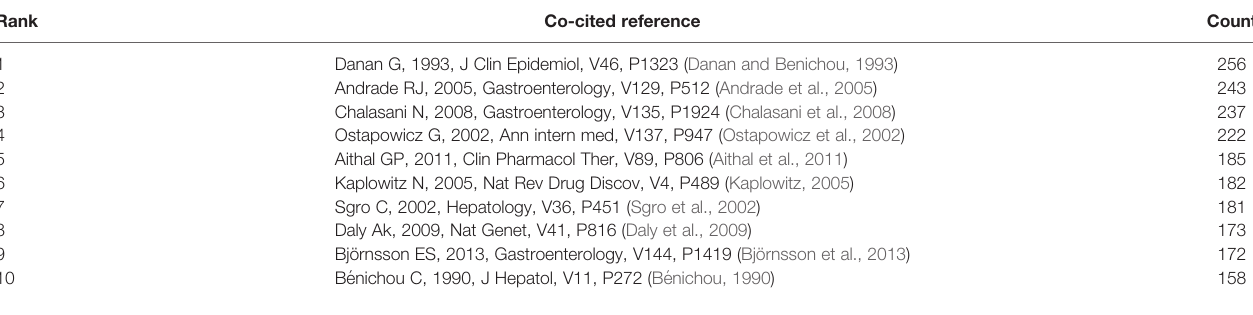
TABLE 4 | The top 10 co-cited references related to DILI